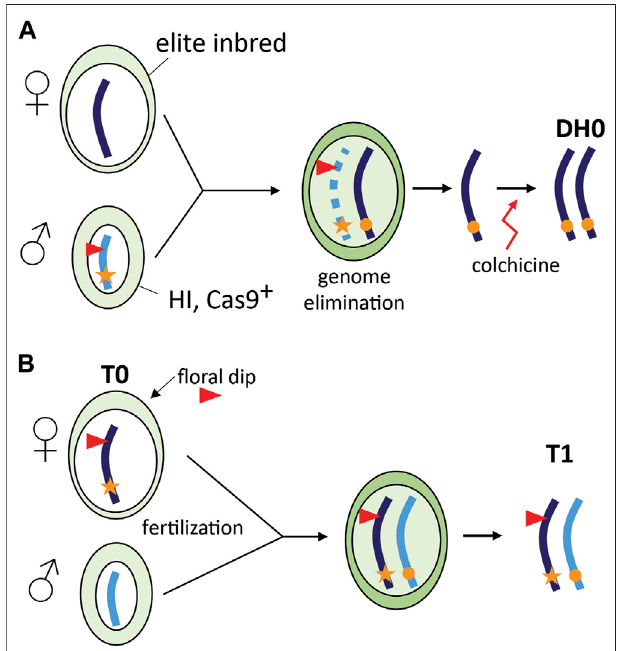
FIGURE 2 | Special cases of TGE. (A) Combining haploid induction and geneediting(HI-Edit)inmaize.AWTelitemaizeinbredlineispollinatedusinga haploid inducer line that contains a CRISPR/Cas9 containing T-DNA locus (red triangle). After fertilization, the male genome is gradually eliminated, but thetemporarypresenceofCRISPR/Cas9maystilledittheeliteallele.After doubling of the haploid plant genome using colchicine, a homozygous edited eliteDH0lineisobtained(Kelliheretal.,2019;Wangetal.,2019). (B) CRISPR/ Cas9 gene editing in Arabidopsis thaliana using fl oral dip. The female gametophyte (T0) is transformed using Agrobacterium tumefaciens leading to a transformed egg cell that may already be edited. Self-pollination with WT pollen leads to a fertilized egg cell and subsequent zygote in which TGE may take